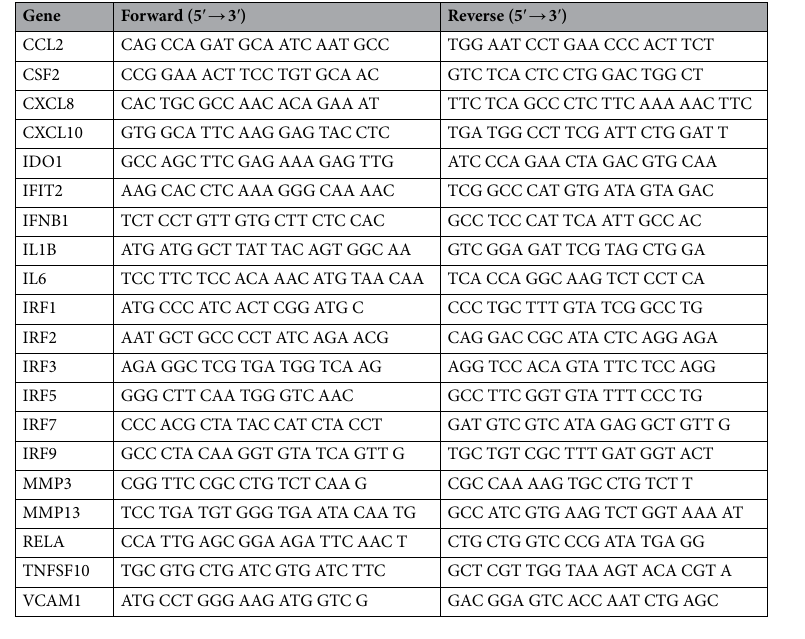
Table 1. List of primers for